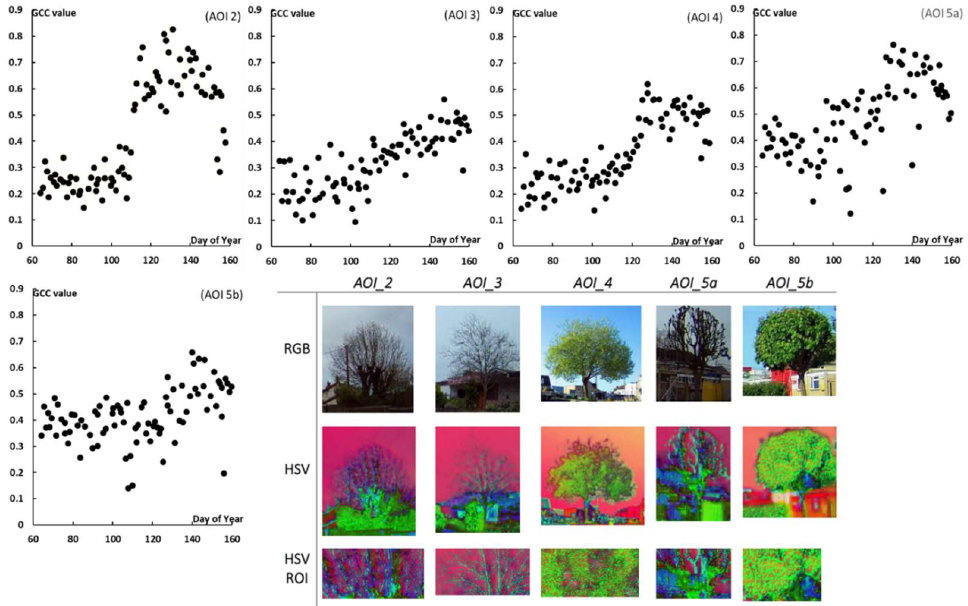
Figure 2. Temporal GCC plotted for AOIs 2, 3, 4, and 5 (two trees) calculated using the ROI HSV; examples of clipped RGB images, the converted HSV image, and the ROI to the HSV colour space, which was then also clipped to new coordinates from each images’ centroid.